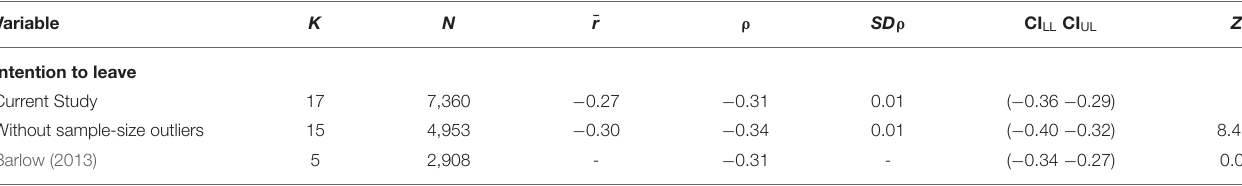
TABLE 1 | Comparison of current and prior meta-analytic results for transformational leadership and intention to leave.